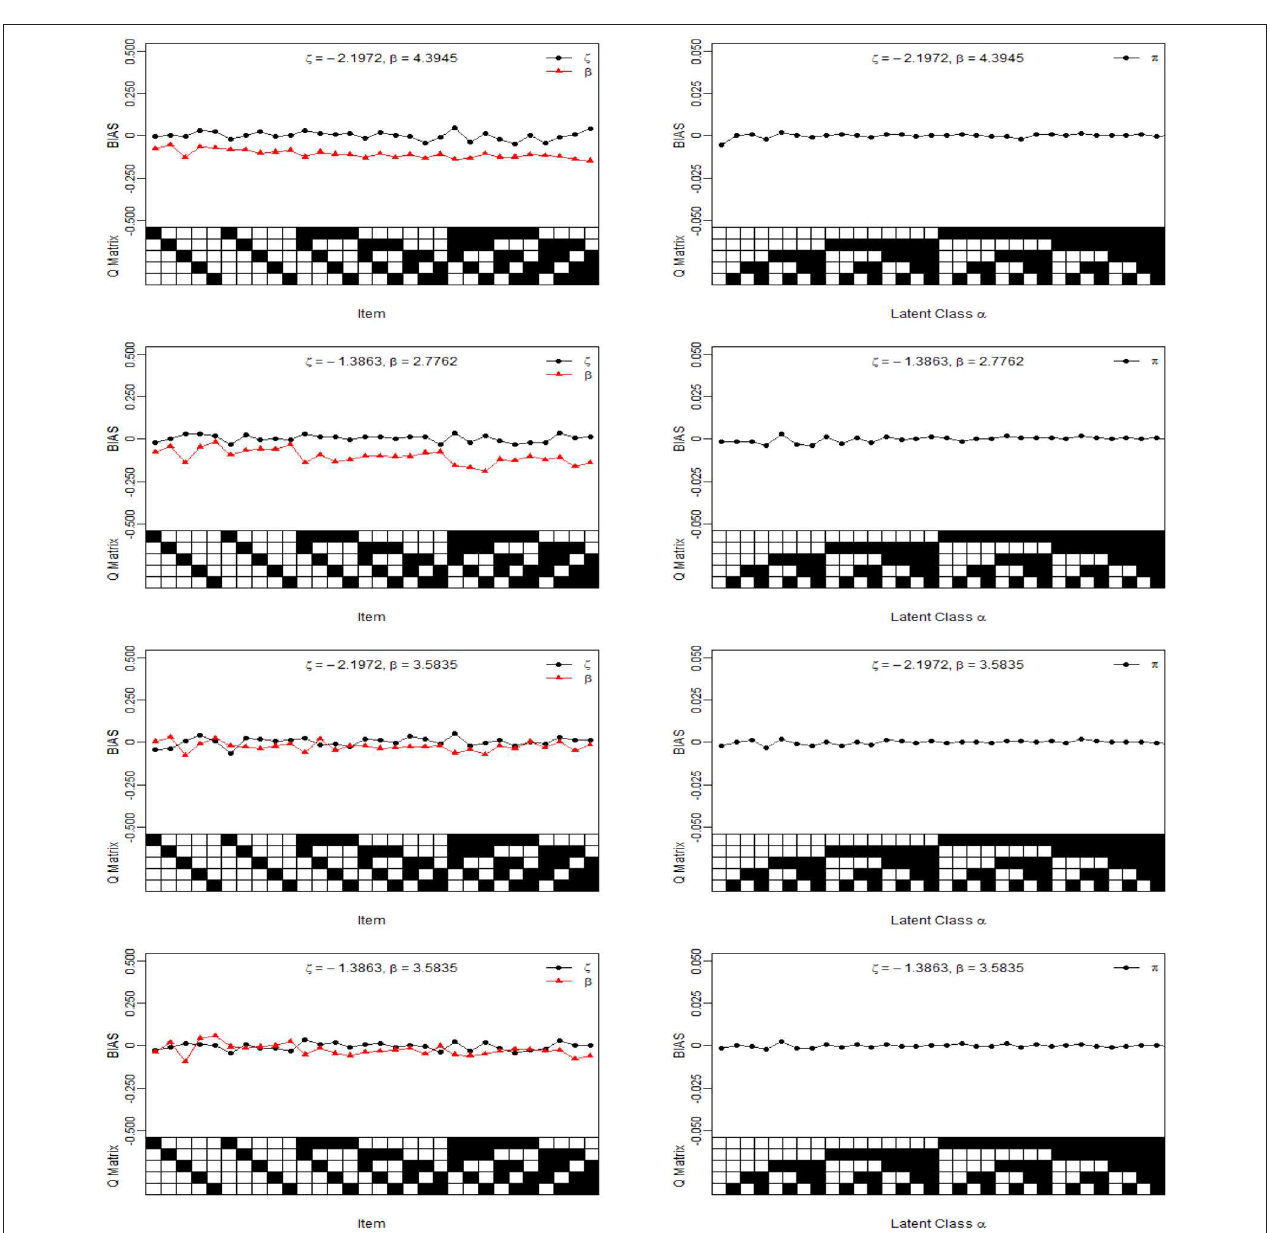
FIGURE 2 | The Bias of intercept, interaction and the latent class parameters under four different noise levels. The Q Matrix denotes the skills required for each item along the x axis, where the black square = “1” and white square = “0.” The α ck denotes the examinee who belongs to the c th latent class whether has mastered k th skill, where the black square = “1” for the presence of a skill and white square = “0” for the absence of a skill, α c = ( α c 1 , ... , α cK ) ′ . Note the Bias values are estimated from 25